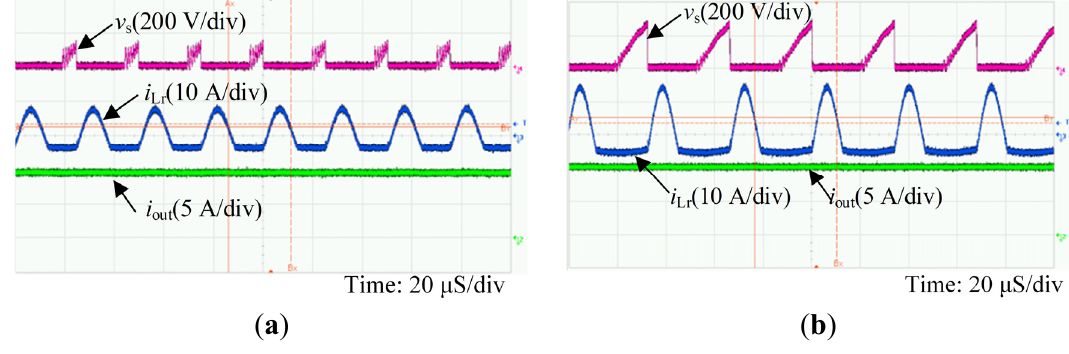
Figure 21. Experimental results under constant current charging: ( a ) 70-V line in; ( b ) 90-V line in. Two groups of experimental results under the constant voltage stage are also compared in Figure 22.